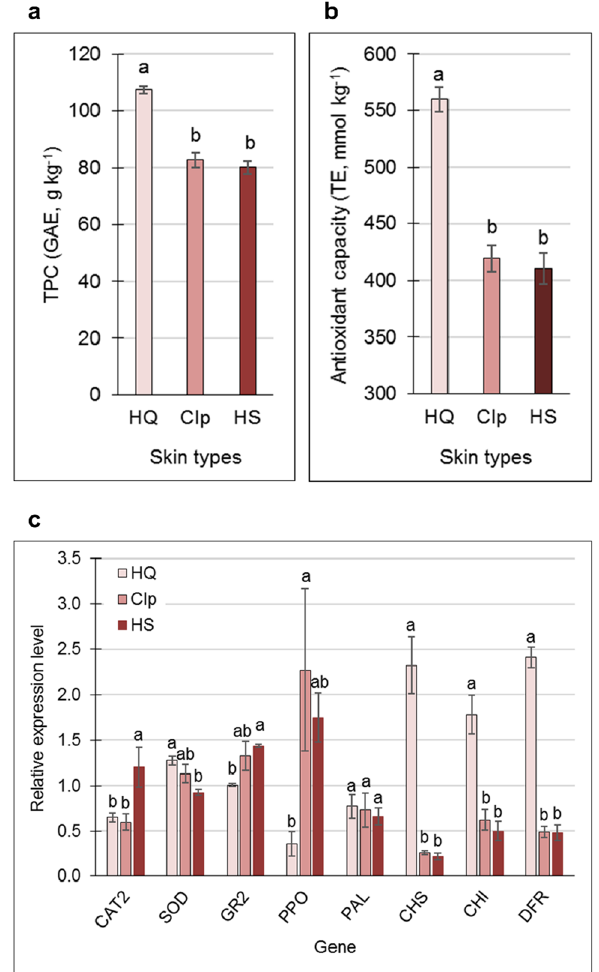
Figure 2. Total polyphenol content (TPC) ( a ), antioxidant capacity ( b ), and the expression of antioxidant- related genes and key anthocyanin-biosynthesis genes ( c ) of skin types shown in Fig. 1. TPC was determined using the Folin–Ciocalteu reagent, and is given as gallic acid equivalents (GAE). Antioxidant capacity was determined using the FRAP method, and is given as Trolox equivalents (TE). Values are averages of three biological replicates ± SE. Data were analyzed for statistical significance among means by Student’s t -test; different letters indicate significantly different values ( P <